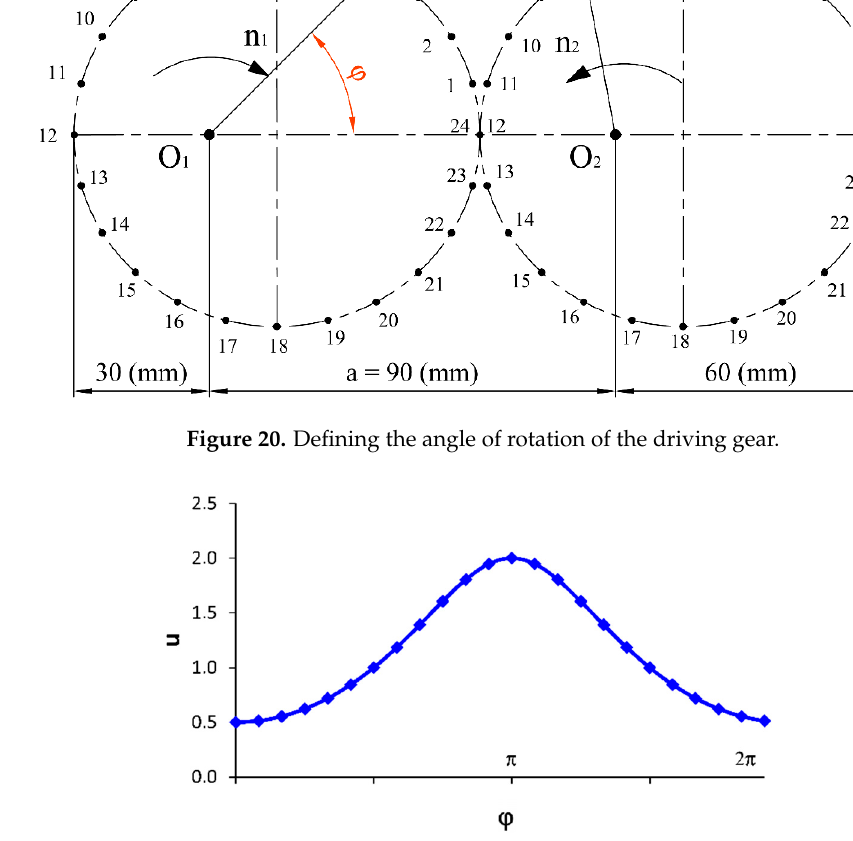
Figure 21. The course of the gear ratio dependent on the angle of rotation of the driving gear.